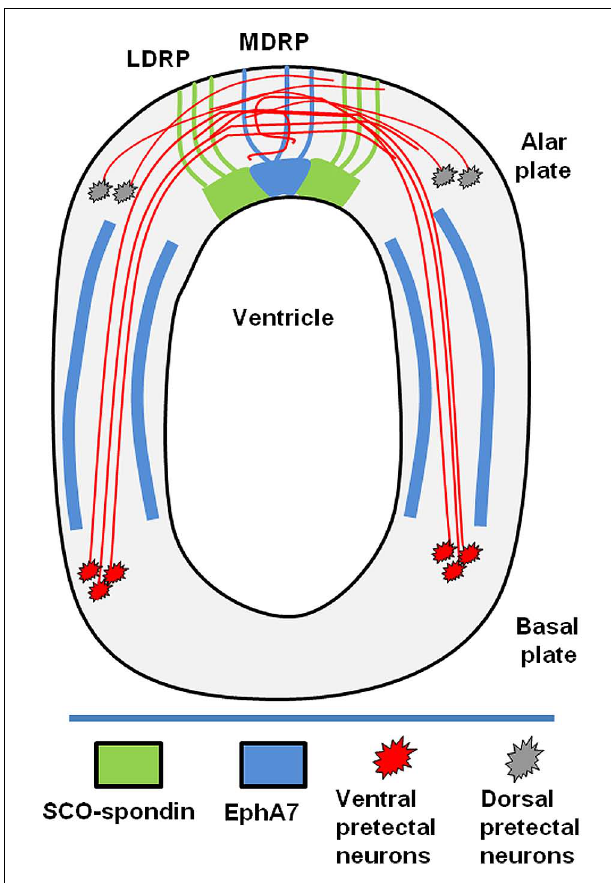
FIGURE 6 | Schematic drawing showing the diencephalic localization of EphA7. The posterior commissure is formed by axons from neurons of the basal plate (red) and alar plate (gray).The axons of the basal plate run dorsally inside of corridors delimited by EphA7 (blue). At the lateral roof plate, SCO-spondin (green) promotes the axonal fasciculation until the midline, where in the presence of EphA7; some of the axons turn to the ipsilateral